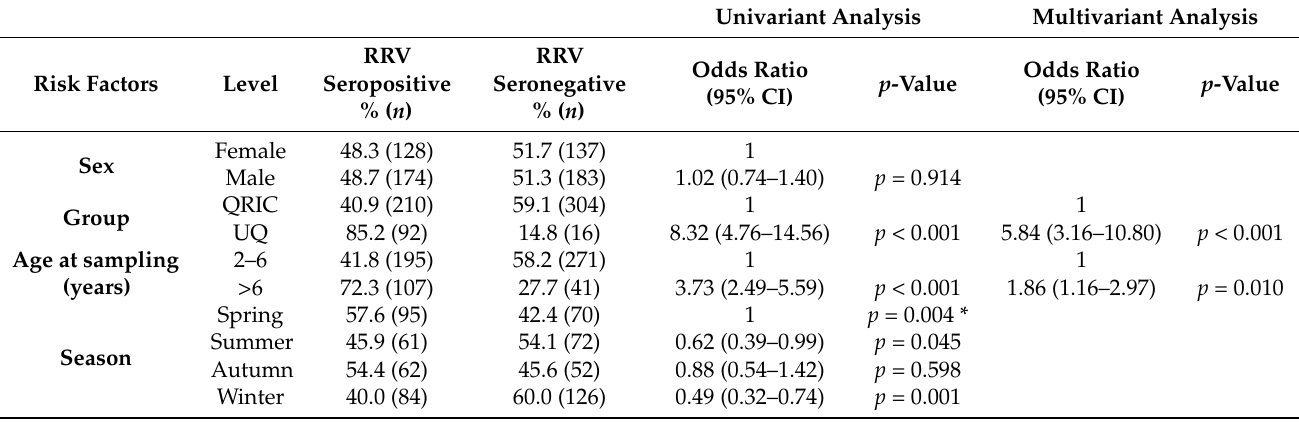
Table 6. Risk factors analysis using logistic regression